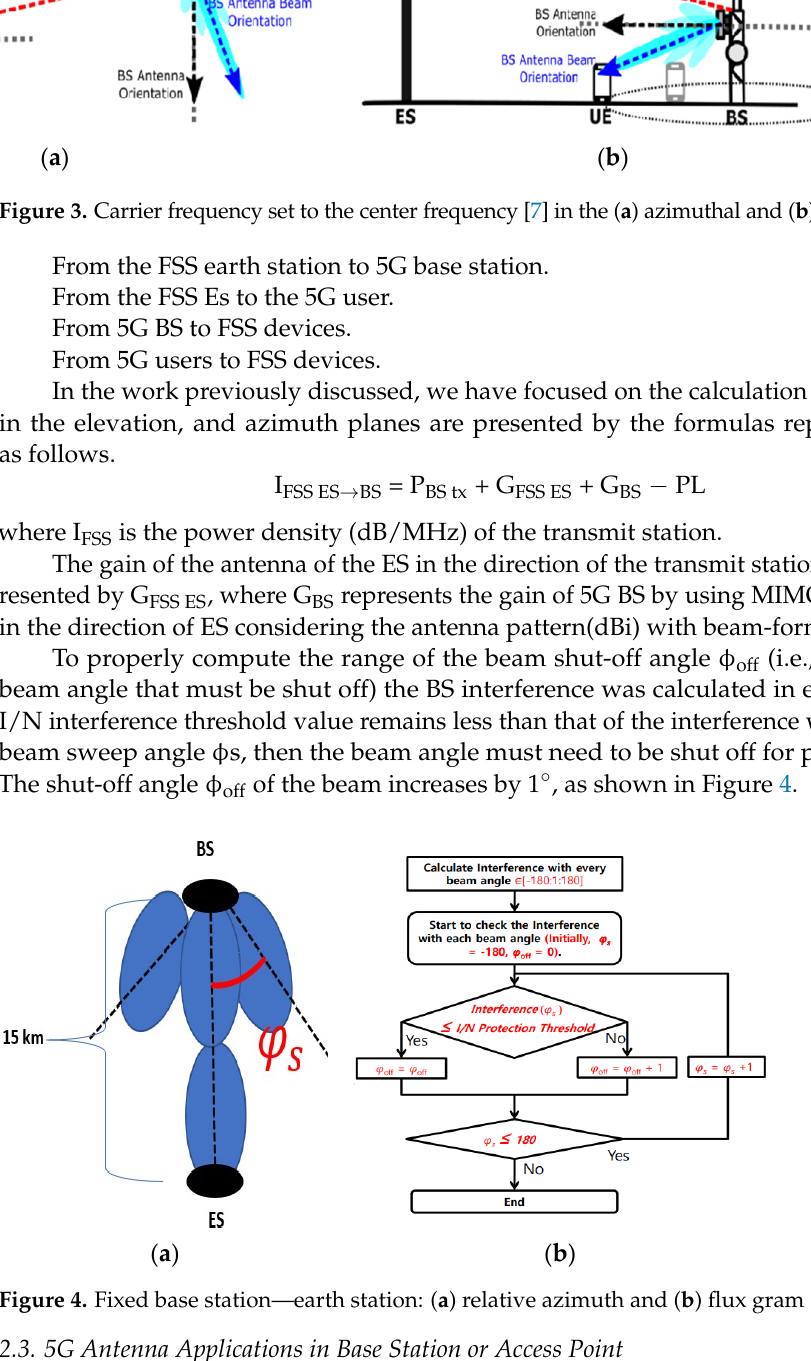
( a ) ( b ) Figure 5. Geometry of the HDI—based filtering 5G patch radiator [35] ( a ) 3D and ( b ) top views. ( a ) ( b )